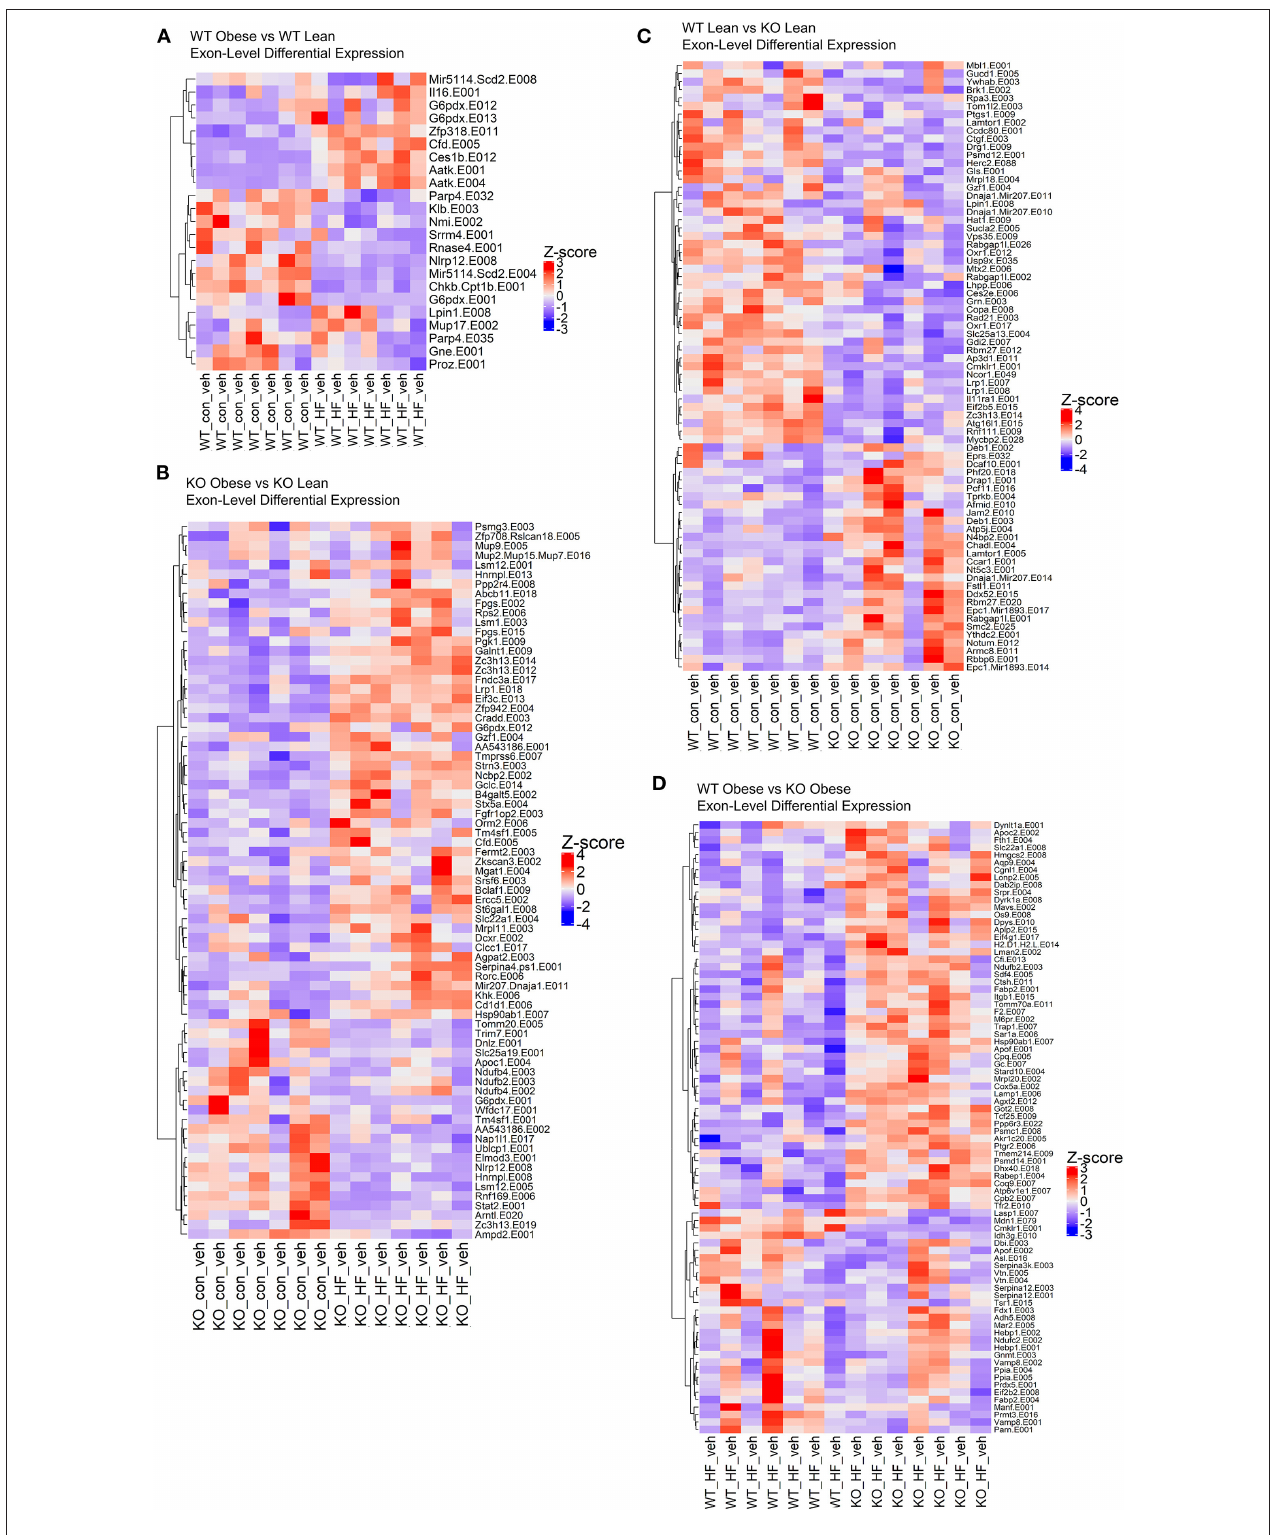
FIGURE 3 | The loss of ChemR23 controls the transcriptional landscape at the exon level. (A) Heatmap of differentially expressed exons between WT obese and WT lean mice. (B) Heatmap of differentially expressed exons between ChemR23 KO obese and ChemR23 KO lean mice. (C) Heatmap of differentially expressed exons between WT lean and ChemR23 KO lean mice. (D) Heatmap of differentially expressed exons between WT obese and ChemR23 KO obese mice. All heatmaps are scaled by Z-score to center all the gene expression values on the same scale. Data are from 7 mice per group.